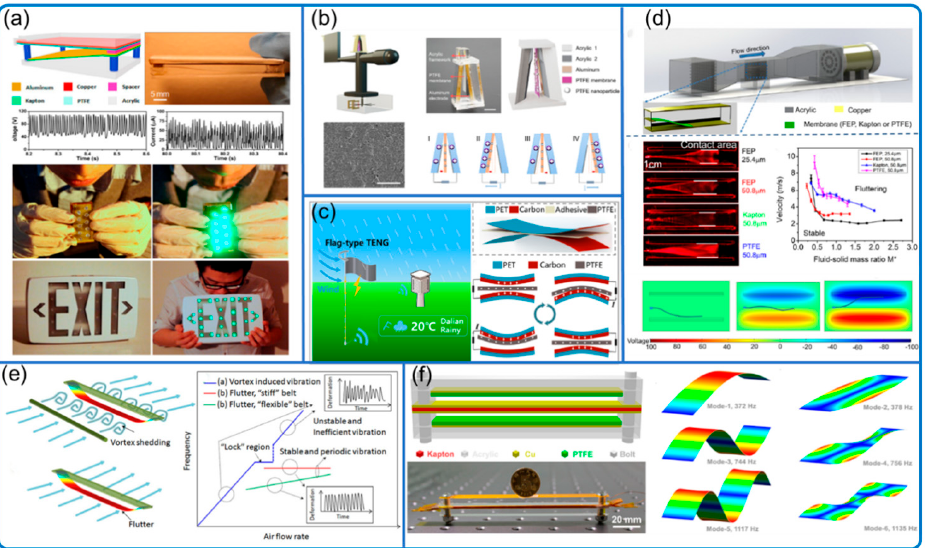
Figure 5. Typical flutter sensor and its mechanism discussion. ( a ) Flutter-type sensor system. Reproduced with permission. Copyright 2013, American Chemical Society [31]. ( b ) Wind vector detecting system. Reproduced with permission. Copyright 2021, Elsevier [43]. ( c ) Flag-type sensor. Reproduced with permission. Copyright 2020, Elsevier [44]. ( d ) Characterization of fluttering behavior and COMSOL simulation. Reproduced with permission. Copyright 2017, Elsevier [35]. ( e ) Theoretical model for flutter phenomenon. Reproduced with permission. Copyright 2016, AAAS [34]. ( f ) Double-clamped aero-elastic system. Reproduced with permission. Copyright 2015, American Chemical Society [39].